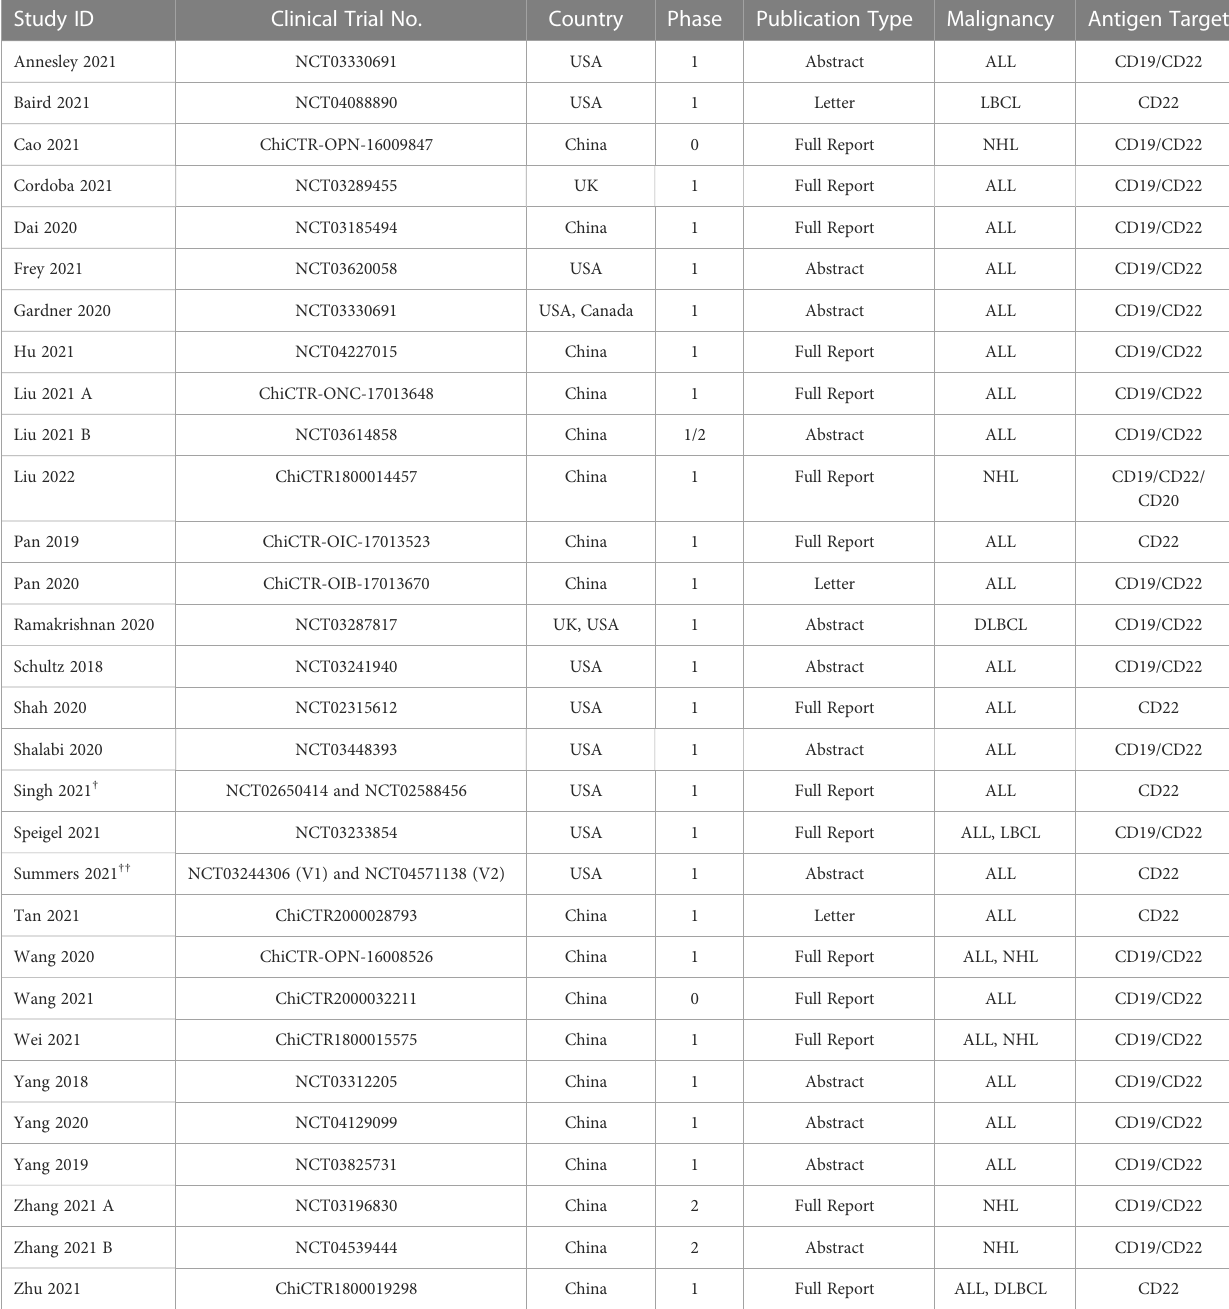
TABLE 1 Study Characteristics of Included Clinical